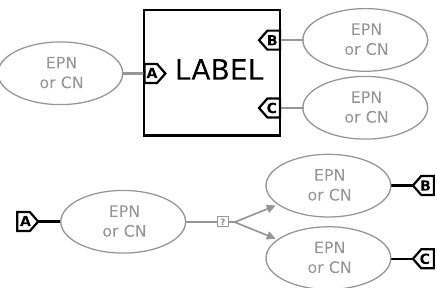
Figure 2.22: The Process Description glyph for submap . (Upper part) folded submap. (Lower part) content of the submap.